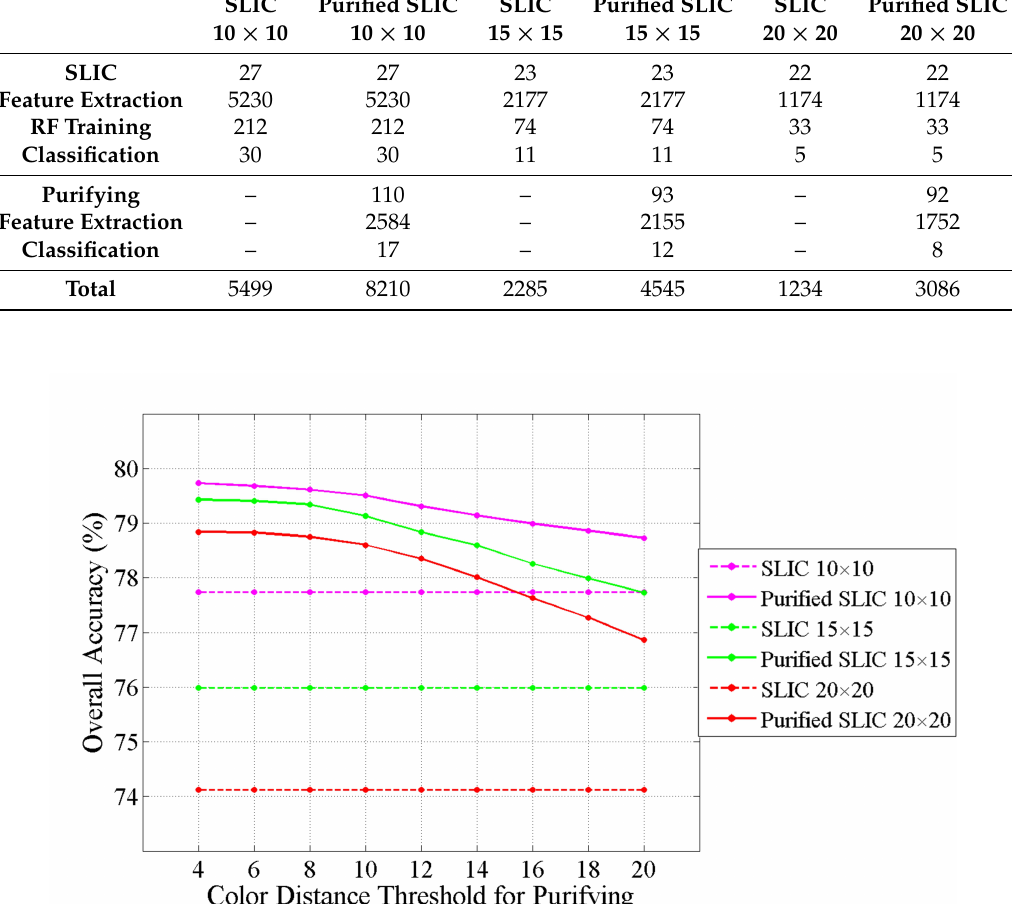
Figure 11. The influence of the color distance threshold T for classification accuracy.